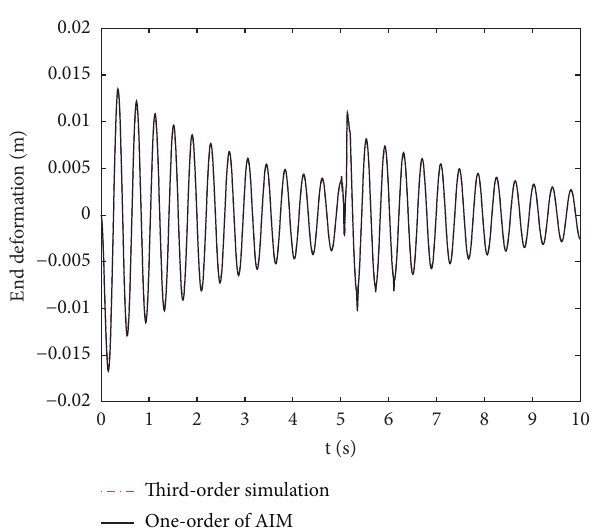
Figure 7: End vibrations with the first-order model and the third- order